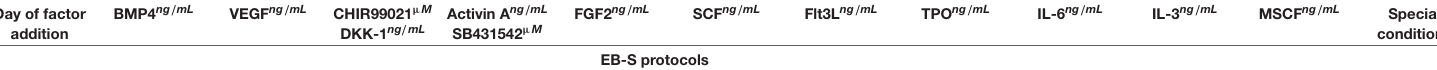
TABLE 5 | Combinations of exogenous factors used to drive iPSC differentiation at the M/HE stage.